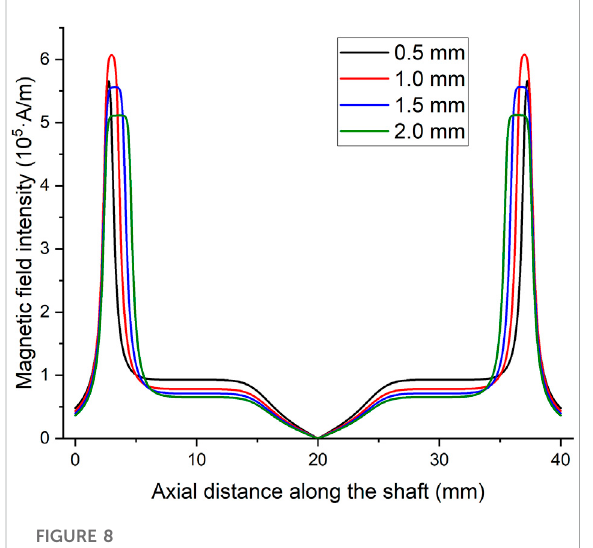
FIGURE 8 Magnetic fi eld intensity in sealing gaps along the axial direction for single pole teeth of different widths.